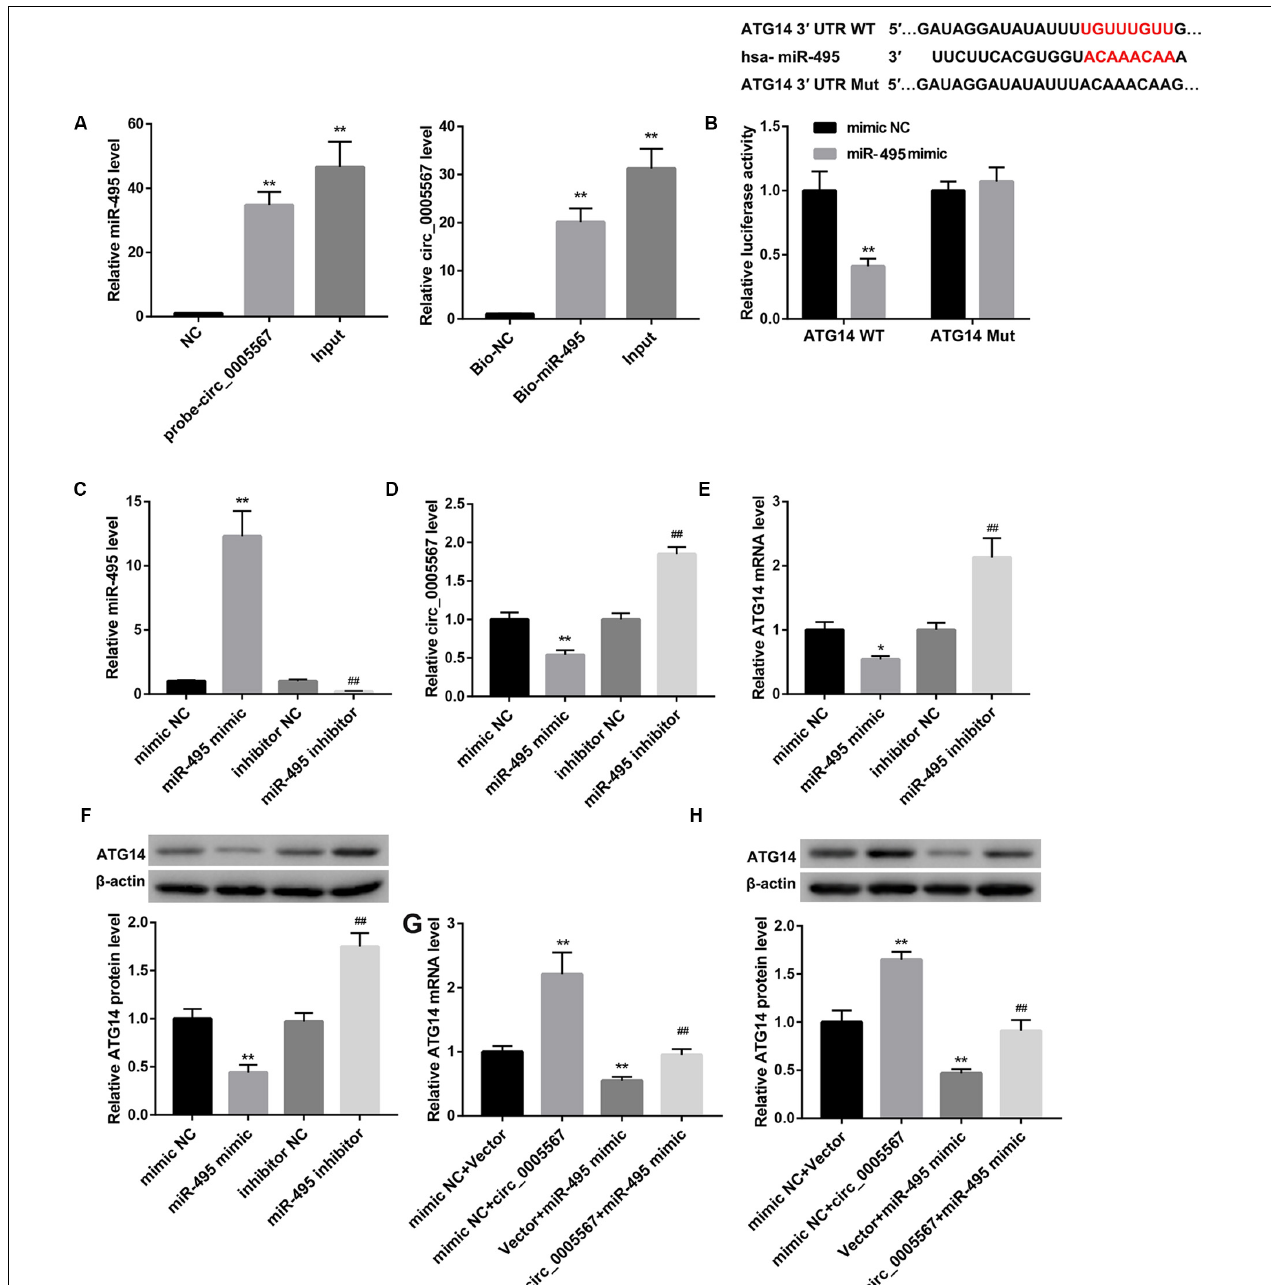
FIGURE 4 | Circ_0005567 derepressed ATG14 expression by sponging miR-495. (A) RNA pull-down was performed to analyze the interaction between circ_0005567 and miR-495. (B) Sequences of the putative miR-495 binding sites in the 3 (cid:48) - UTR of ATG14. Luciferase activity in chondrocytes co-transfected with wild type (WT) or mutant (Mut) ATG14 3 (cid:48) -UTR luciferase reporter plasmids and miR-495 mimics or mimic NC. (C) MiR-495 expression, (D) circ_0005567 expression, (E) ATG14 mRNA level, and (F) ATG14 protein level in chondrocytes transfected with miR-495 mimic, mimic NC, miR-495 inhibitor, and inhibitor NC. (G) ATG14 mRNA level and (H) ATG14 protein level in chondrocytes co-transfected with miR-495 mimic/mimic NC and circ_0005567 overexpression vector/empty vector. The data are expressed as mean ± standard deviation from three independent experiments. * P < 0.05, ** P < 0.01, versus the NC or mimic NC or mimic NC + Vector group; ## P < 0.01, versus the inhibitor NC or mimic NC + circ_0005567 or Vector + miR-495 mimic group.